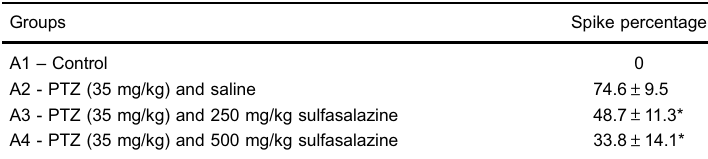
Table 1. Results from the EEG